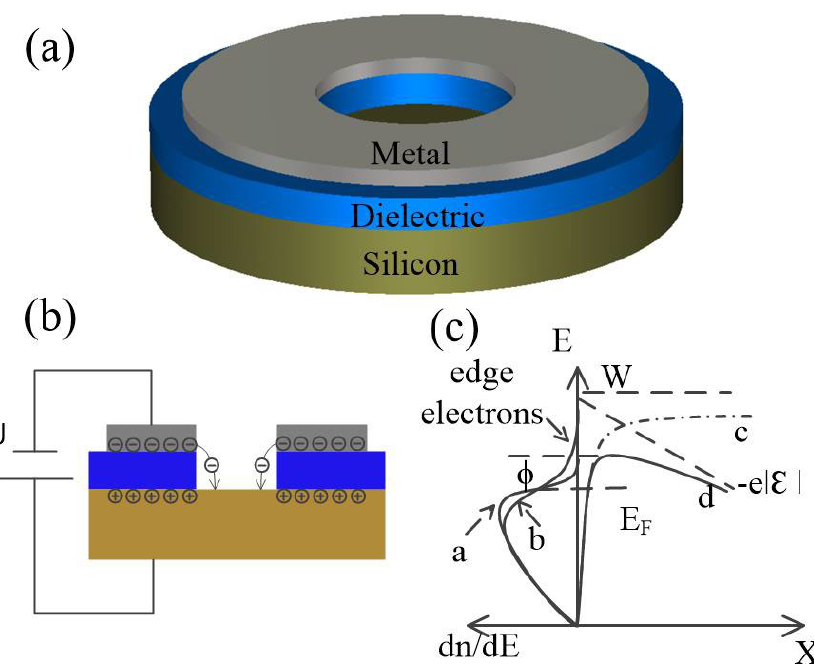
Figure 1. The vacuum diode temperature-sensing element. ( a ) Schematic of the proposed temperature-sensing diode; ( b ) Schematic illustration of electrons emission and transportation in the vacuum channel. Electrons will be ejected from the edge of 2DES, travelling from metal to silicon via vacuum channel; ( c ) Diagram of electron distribution by energy in cathode and surface barrier distribution. W is the height of surface vacuum barrier. E F is the Fermi level of cathode. Line a is normal electron distribution in metal, which we deliberately show here as a reference. Line b is electron distribution in metal, where 2DES developed under certain bias. Line c is surface barrier distribution of electrons without external electric field. Line d is surface barrier distribution of electrons under external electric field.